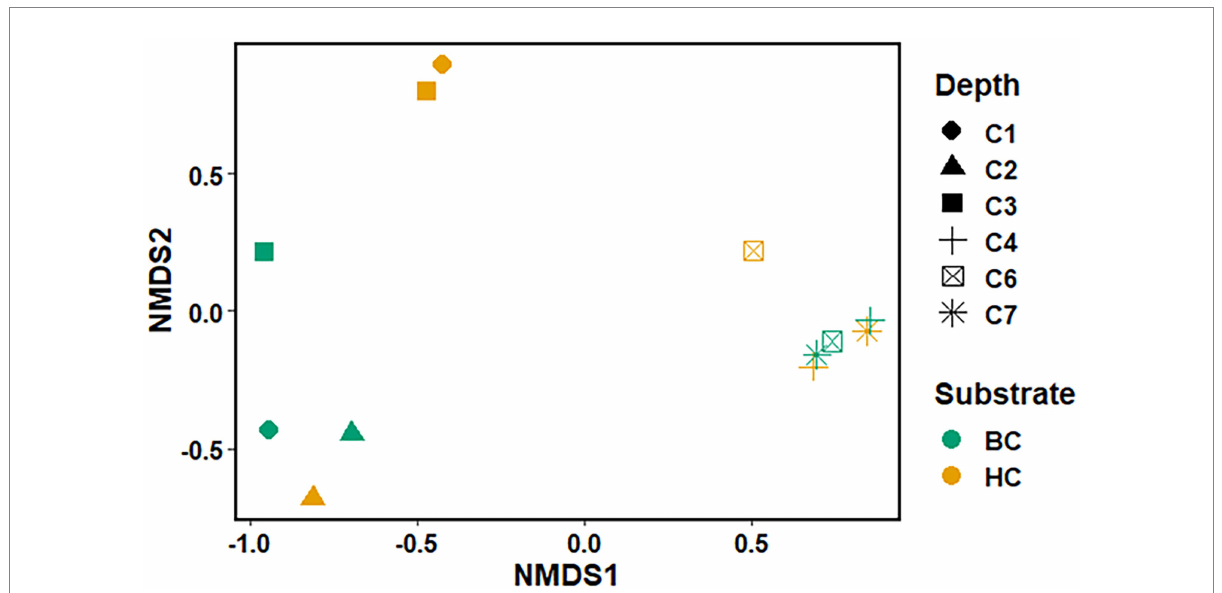
FIGURE 5 Non-metric Multidimensional scaling of microbial community (at the taxa level) for microbial taxa belonging HC and BC enrichment based on their association with